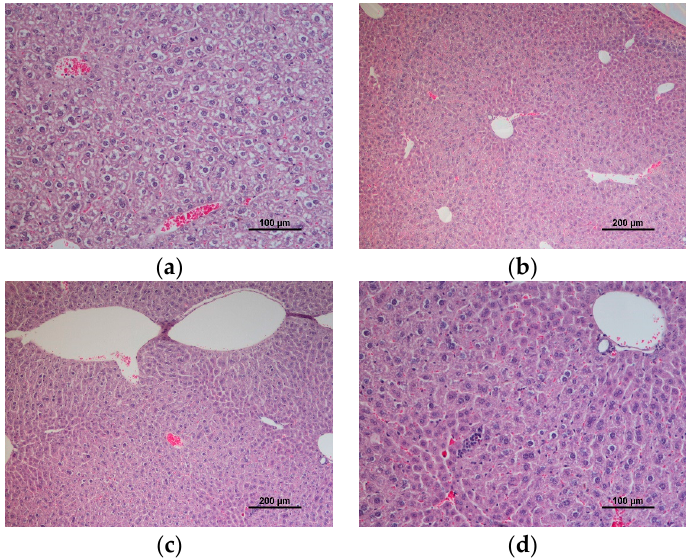
Figure 4. Microscopic images (staining with H&E) of liver sections from the different groups under study. ( a ) Cellular tumefaction and hydropic changes in a mouse’s liver from the control group, 200×. ( b ) Hydropic changes observable only in the centrilobular region of an animal’s liver from EE12, 100×. ( c ) Cellular tumefaction and centrilobular hydropic changes in a mouse’s liver from EE24, 100×. ( d ) Cellular tumefaction, centrilobular hydropic changes, and multifocal inflammatory infiltration in an animal from EE48, 200×.